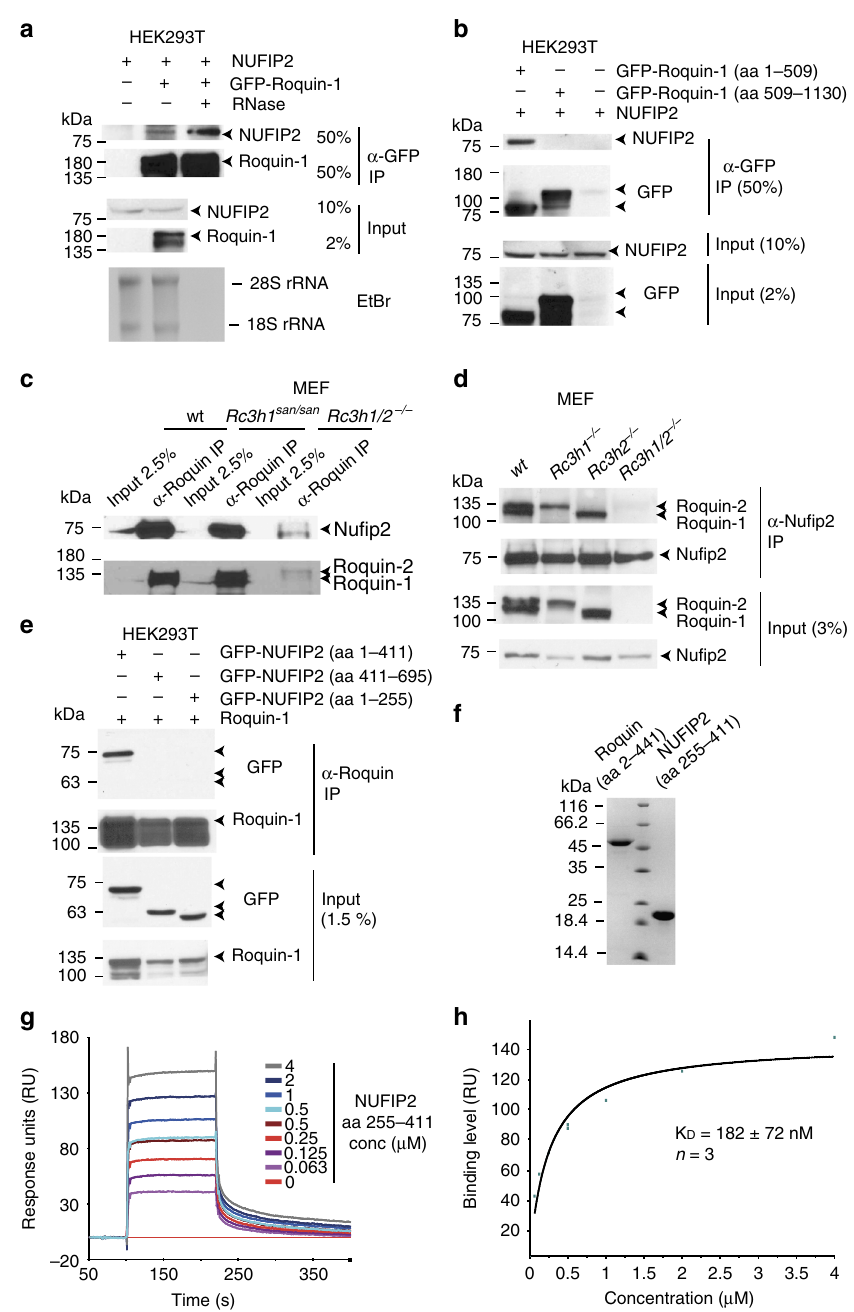
Fig. 5 Direct physical interaction between Nu fi p2 and Roquin. Immunoblots were analyzed with antibodies against Nu fi p2 and Roquin, Roquin and GFP or Nu fi p2 and GFP. Anti-GFP or anti-Roquin immunoprecipitation from lysates of HEK293T cells transfected with the indicated expression vectors ( a , b , e ) and anti-Roquin ( c ) or anti-Nu fi p2 ( d ) immunoprecipitation of endogenous proteins from MEF cells of the indicated genotypes are shown. a Extracts were treated during immunoprecipitation with or without RNase as indicated and degradation of rRNA by RNase treatment was con fi rmed by ethidium bromide (EtBr) staining of RNA extracts from IP supernatants. f Representative coomassie-stained PAGE of puri fi ed Roquin-1 (aa 2 – 441) and NUFIP2 (aa 255 – 411) proteins. g , h Surface plasmon resonance study of the binding of NUFIP2 (aa 255 – 411) to immobilized Roquin-1 (aa 2 – 441). g Biacore sensogram recording the binding of NUFIP2 (aa 255 – 441) injected at two-fold serial dilutions ranging from 0.063 to 4 μ M to Roquin-1 (aa 2 – 441). After the highest concentration, the 0.5 μ M sample dilution was re-injected to assess potential accumulation of unspeci fi c background binding. h Steady-state af fi nity analysis of the binding level in response units (RUs) against the Nu fi p2 (aa 255 – 411) protein concentration shown in a representative fi tting curve. In a – e and g – h one representative of two ( d ) or three ( a – c , e , g – h ) independent experiments is shown. The K D in h was calculated from mean and SD of